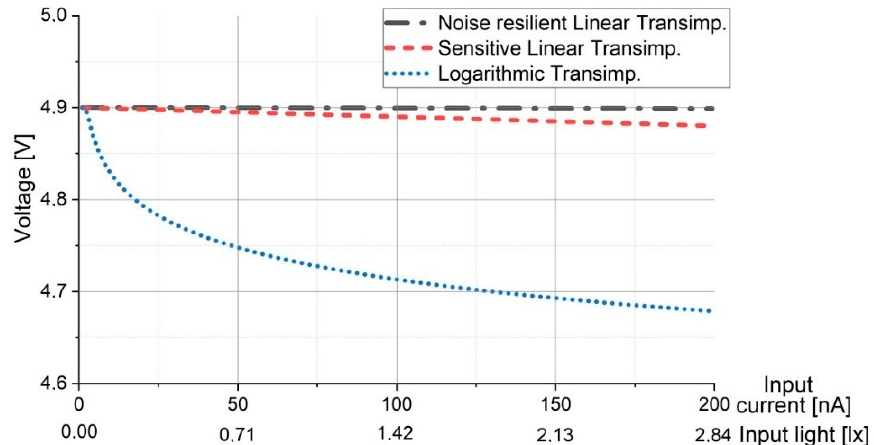
Figure 3. Evaluation of the logarithmic transimpedance circuit and its comparison to the noise resilient linear circuit and to high sensibility linear circuit in low lighting conditions. The simulation results show that in low lighting conditions, the noise resilient linear circuit does not respond to light intensity variations due to its low sensitivity, whereas the logarithmic transimpedance circuit automatically increases its